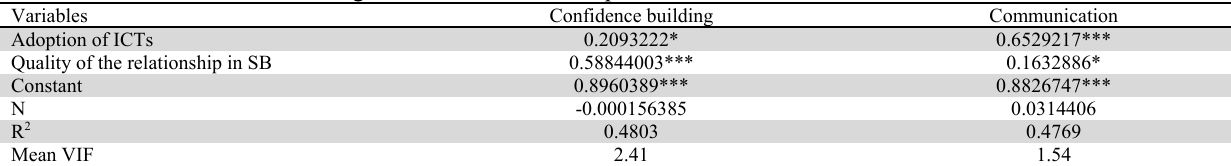
Results of the structural model using TLS with 95% bootstrap CI Variables